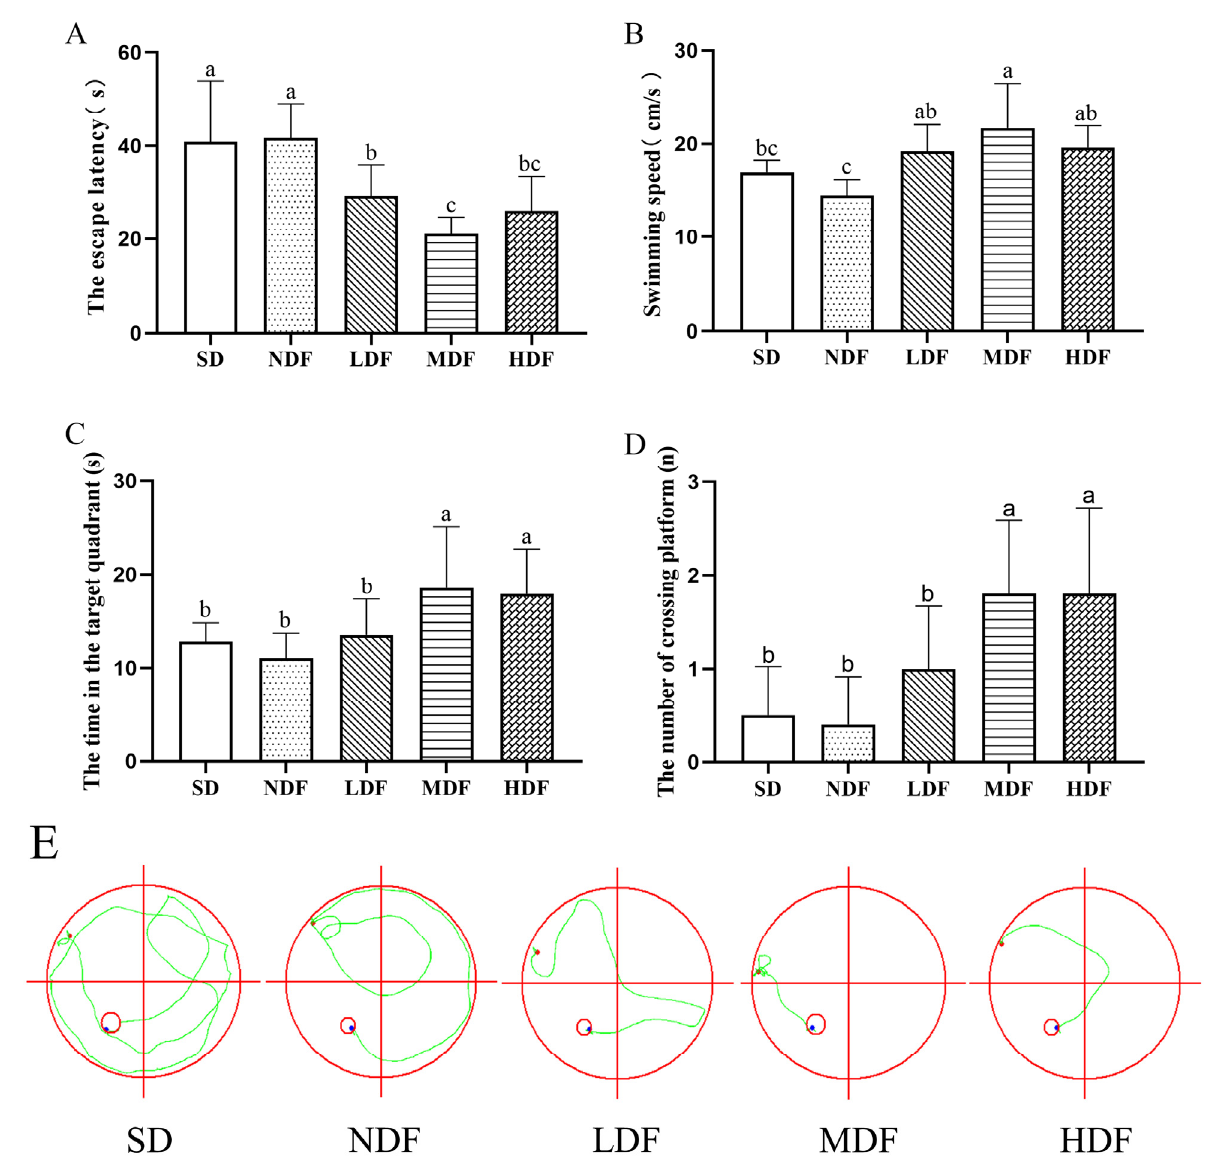
Figure 2. The spatial learning and memory capacity of the mice were tested and analyzed using the Morris water maze over 4 days ( n = 10): ( A ) Escape latency; ( B ) swimming speed; ( C ) time spent in target quadrant; ( D ) the number of times crossing the platform. Different superscript letters denote a significant difference in the same index ( p < 0.05). ( E ) the swimming trajectory of the different groups during the 60 s probe (the red circle is the exploration area; the green line is the trajectory; the red dot is the starting point; the blue dot is the ending).